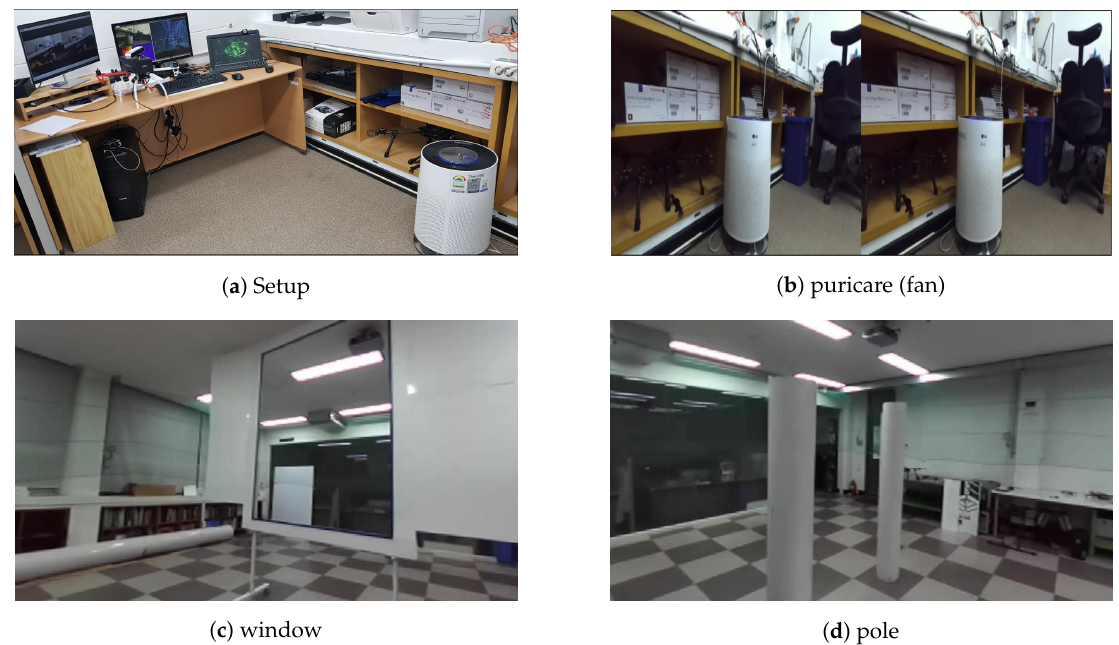
Figure 1. Experimental setup and sample stereo images of objects used to train the network.